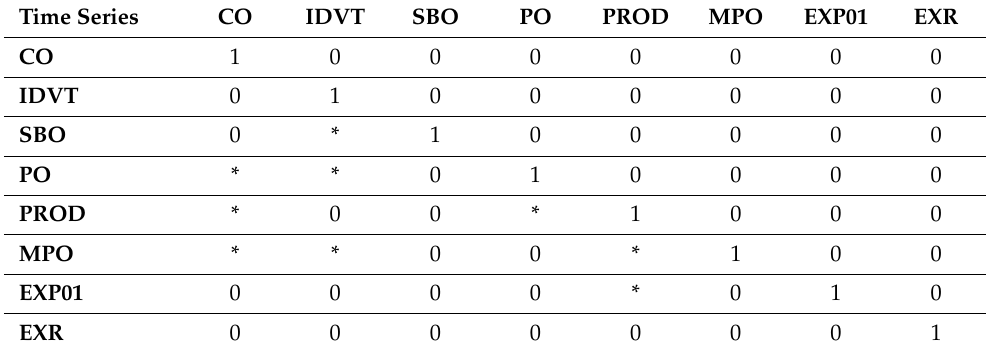
Table 8. The revised restrictions table. The ‘*’ means the figures are estimated by the estimating